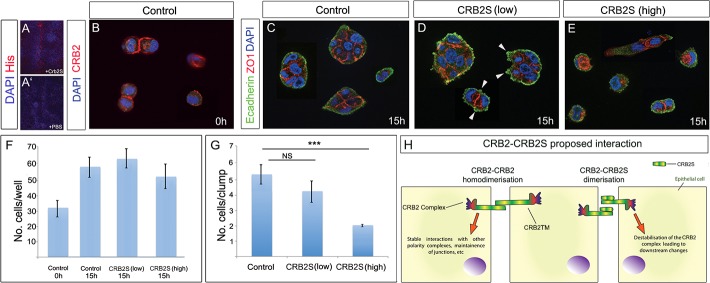
CRB2S reduces cohesion/adhesion in MDCK cells.(A,A′) Transverse sections of E15.5 spinal cord incubated with His-tagged CRB2S (A) or PBS (A′). Anti-His antibody detects CRB2S at the apical side of VL cells. (B) MDCK cells seeded at low density express CRB2 at junctions between doublets. (C-E) MDCK cells seeded at low density, then cultured an additional 15 hours in control medium (C), low concentration of CRB2S (D), or high concentration of CRB2S (E). Arrowheads in (D) point to blebs. (F,G) Quantitative analyses show that CRB2S does not affect the total cell number but significantly reduces the number of cells/clumps. Underlying data can be found in S7 and S8 Tables. (H) Model for effect of CRB2S. In the absence of CRB2S, CRB2TM binds homophilically [63] to promote stable interactions with components of the apical polarity/junctional complex and maintain neuroepithelial junctions. CRB2S competes homophilically to bind to CRB2. CRB2-CRB2S dimerisation destablilises the CRB2 complex, leading to downstream neuroepithelial destabilisation and delamination. CRB2, Crumbs2; CRB2S, secreted Crumbs2; CRB2TM, transmembrane CRB2; MDCK, Madin-Darby kidney cells; NS, non-significant; VL, ventricular layer; ZO-1, Zona occludens 1.